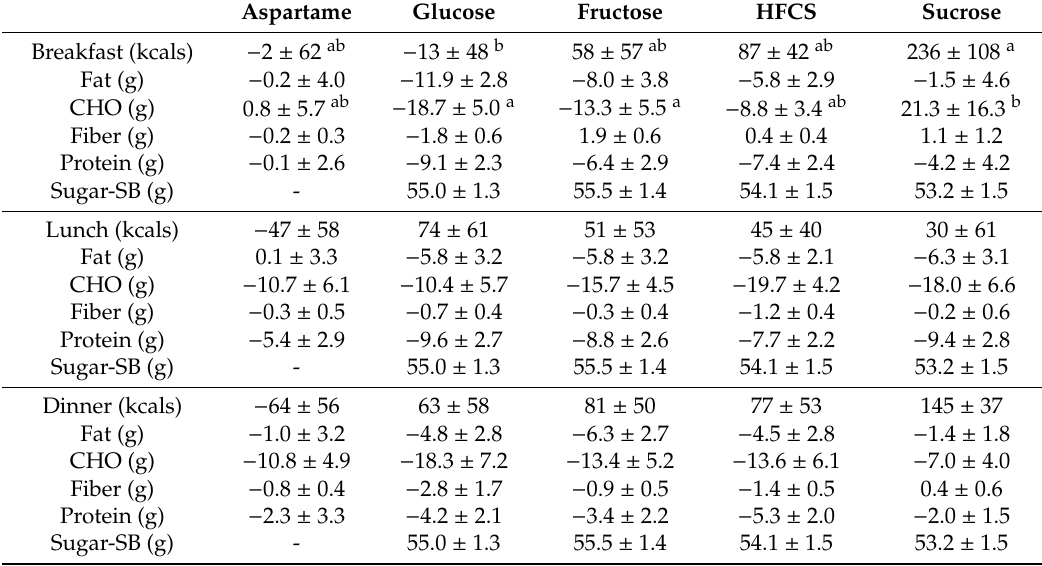
Table 3. Change in energy and macronutrient intake (Week 2 – Week 0) during ad libitum food intake trials 1 .